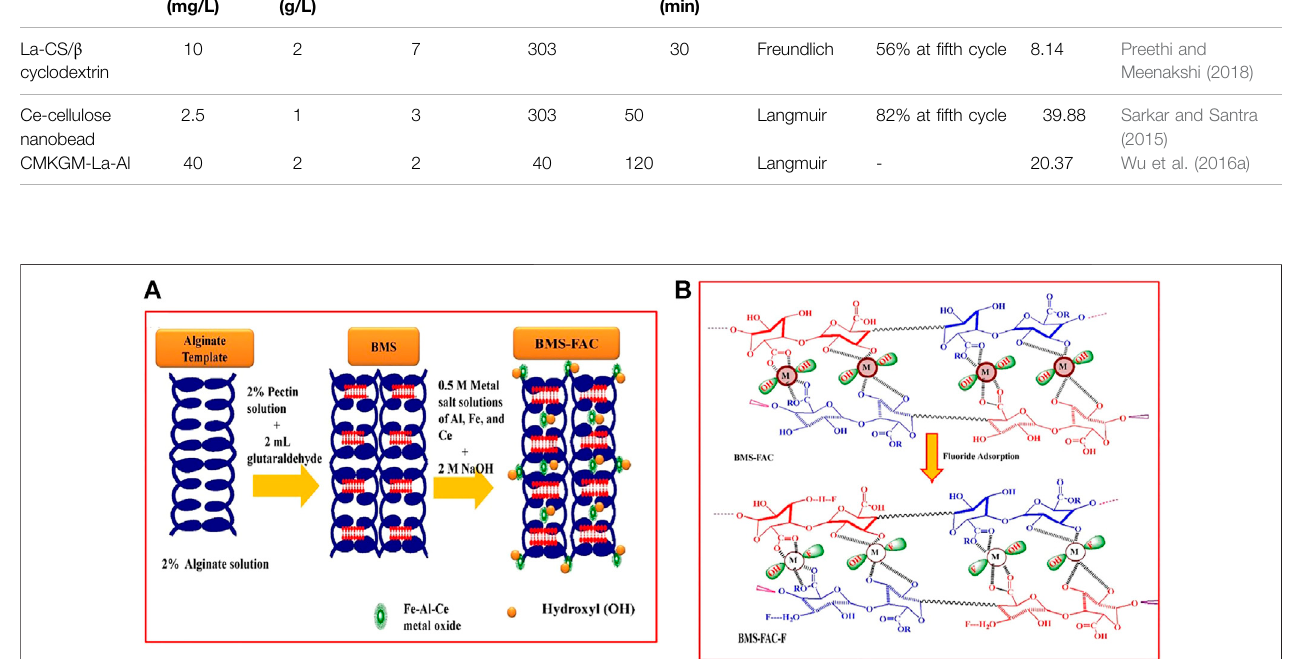
FIGURE 5 | Schematic principle (A) and fl uoride adsorption mechanism (B) of multi-metal – modi fi ed sodium alginate and pectin (Raghav et al., 2019).